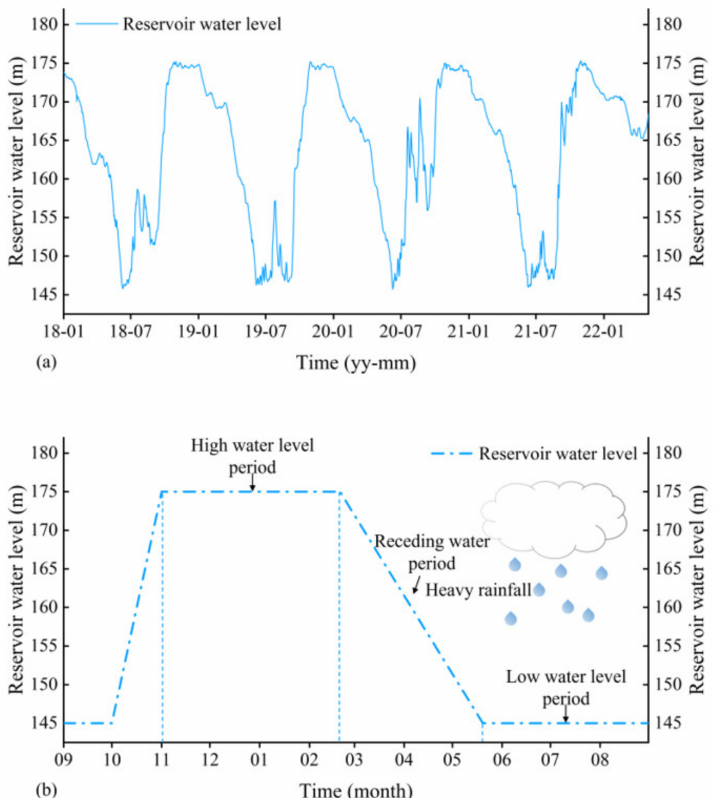
Figure 2. ( a ) Reservoir water level change curve (2018–2022); and ( b ) Time division of reservoir water level change in a cycle.